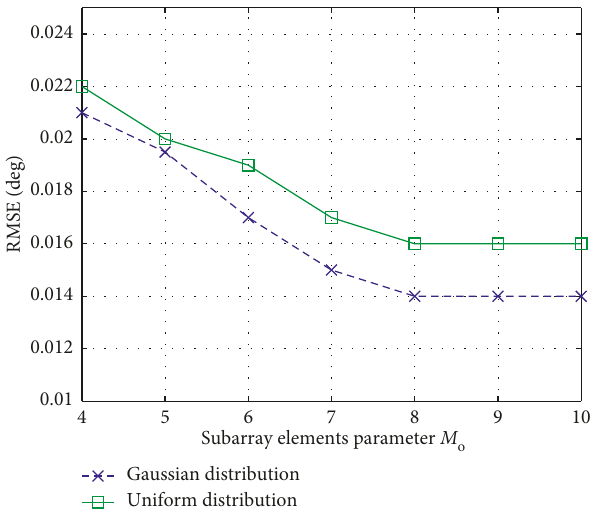
Figure 7: RMSE estimated by the proposed versus M